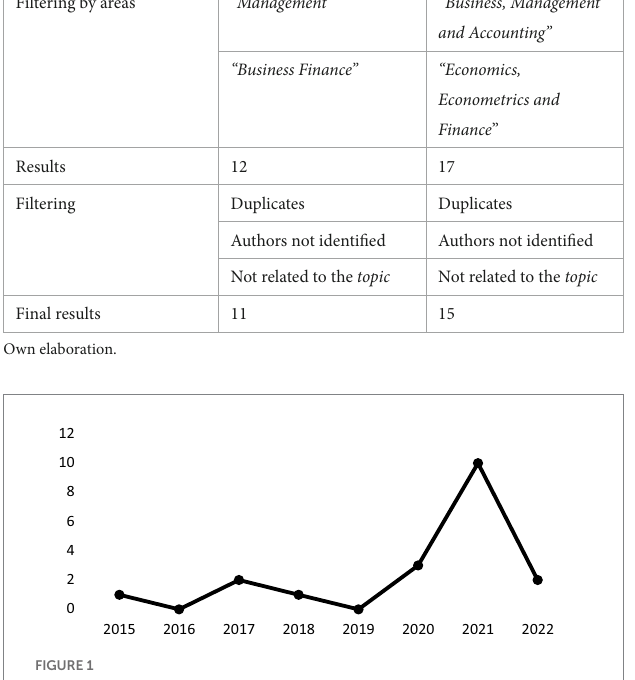
FIGURE 1 Time evolution of publications. Own